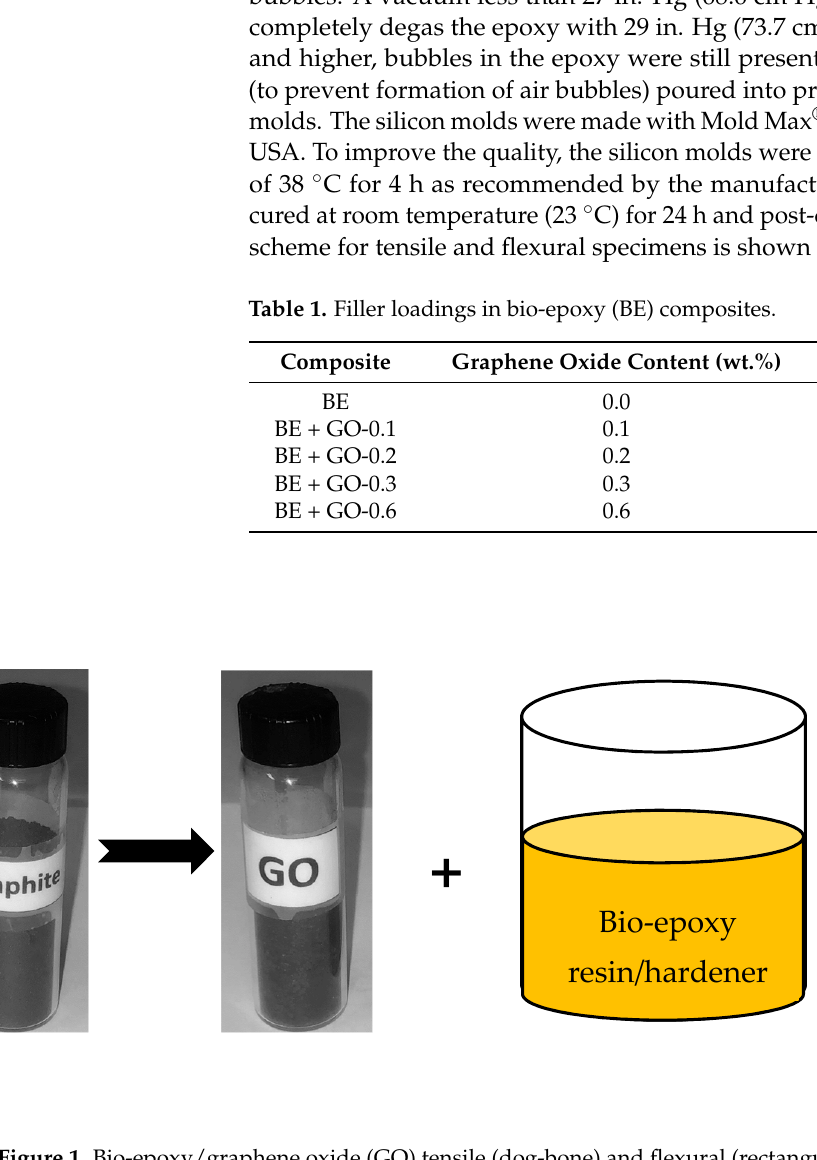
Figure 1. Bio-epoxy/graphene oxide (GO) tensile (dog-bone) and flexural (rectangular) composite preparation route.